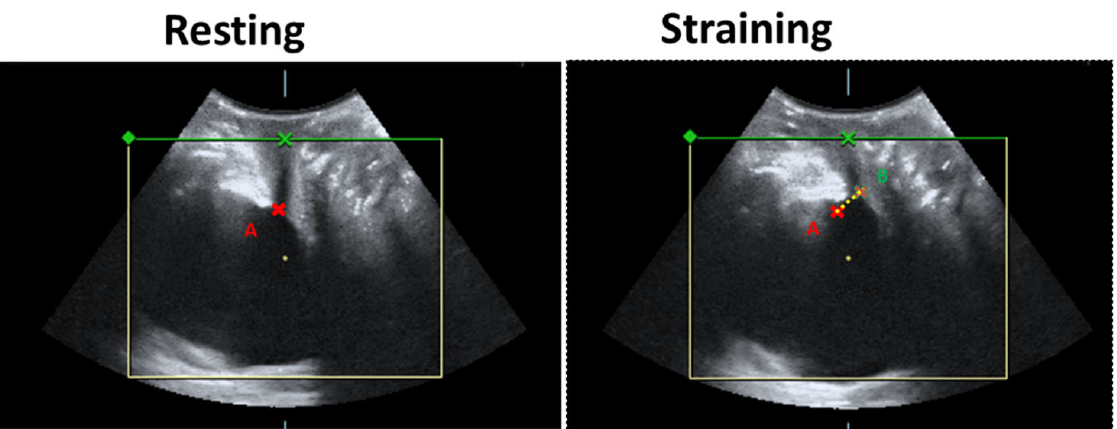
Figure 1. Bladder neck mobility from resting to straining. A, bladder neck at rest. B, bladder neck during straining.